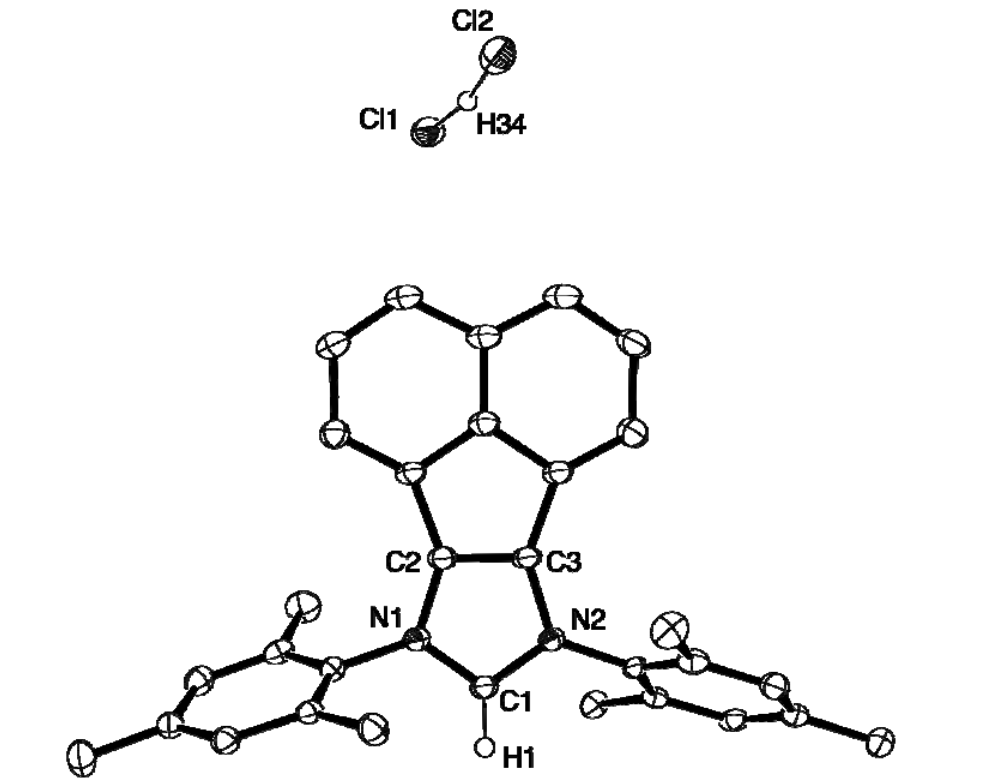
Figure 3. ORTEP diagram of 2 with 50% probability thermal ellipsoids. Hydrogen atoms except H1 and H34 are omitted for clarity.